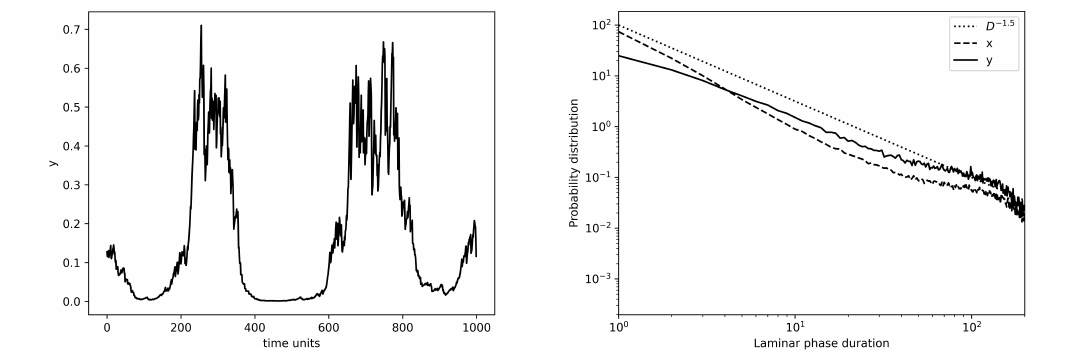
Figure 8. ( Left panel) Time series of y in case α = 2.1; ( Right panel) Laminar phase durations of the x (dashed) and y (solid) variables for stochastic K 0 with α = 2.1. The dotted line is proportional to D − 3 2